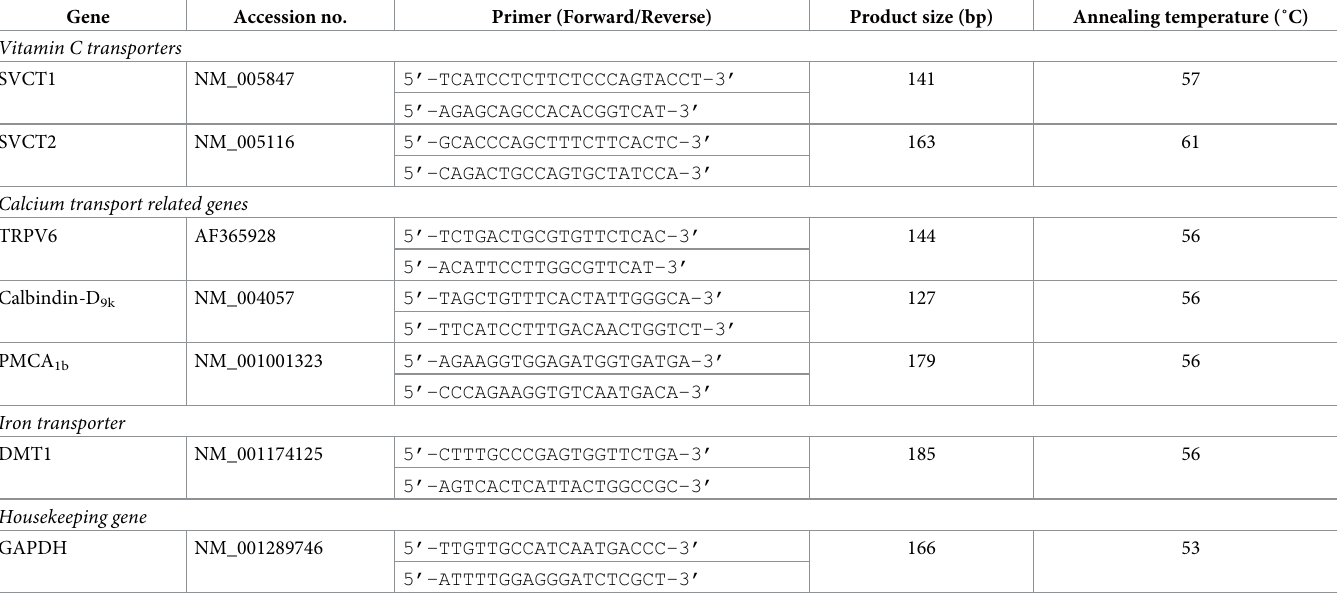
Table 1. Homo sapiens primers used in real-time